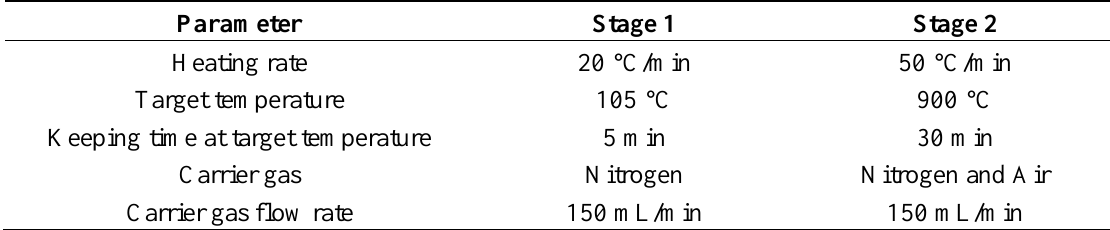
Table 4. Thermal gravimetric analysis